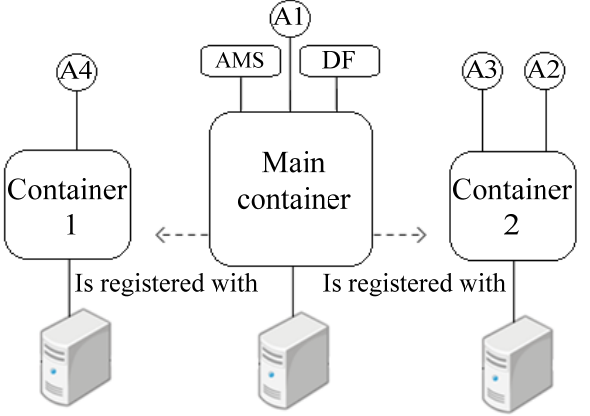
Figure 3. Java Agent Development Framework (JADE) system